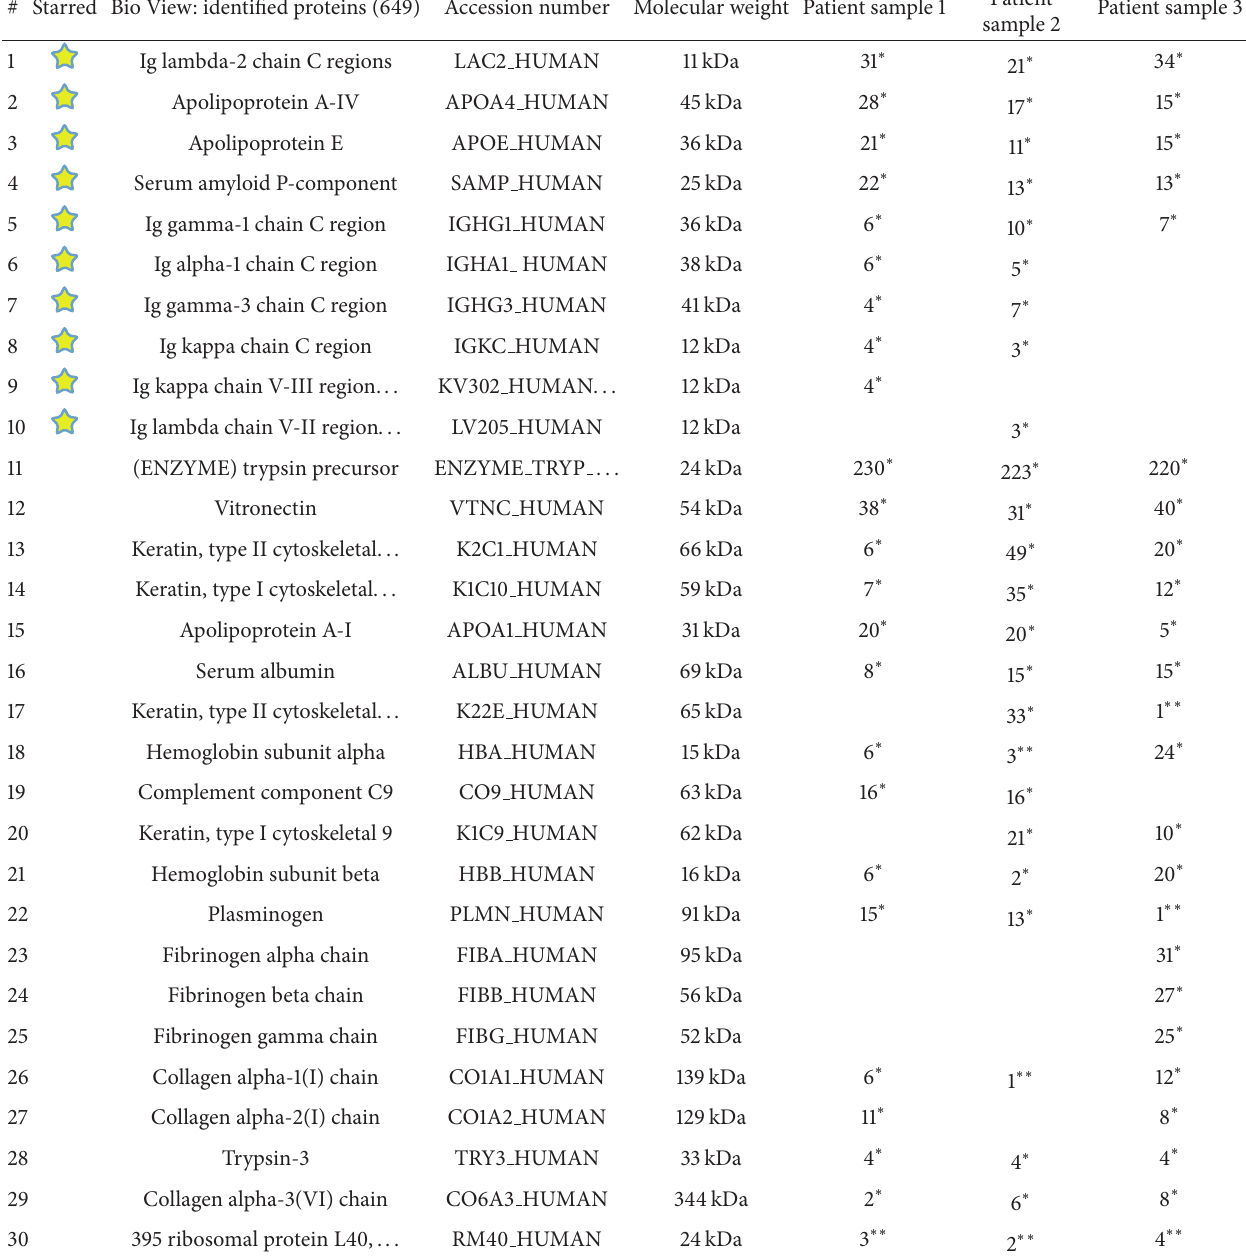
# Starred Bio View: identified proteins (649) Accession number Molecular weight Patient sample